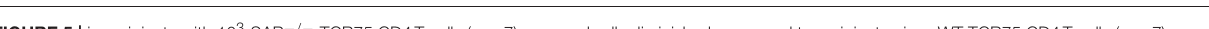
FIGURE 5 | in recipients with 10 3 SAP − / − TCR75 CD4T cells ( n = 7) was markedly diminished compared to recipients given WT TCR75 CD4T cells ( n = 7); * P < 0.001, two-way ANOVA. (C) Whereas BALB/c heart allografts survived long-term in BL/6 Tcrbd − / − recipients reconstituted with 10 3 SAP − / − TCR75 CD4T cells ( n = 7), allografts were rejected in recipients given 1 × 10 3 WT (SAP + / + ) TCR75 CD4T cells ( n = 7, MST-50 days; P < 0.001, log-rank test). (D) Severity of vasculopathy (left) and parenchymal damage (right) in BALB/c hearts explanted: from unmodified (non-reconstituted) BL/6 Tcrbd − / − mice (day 50, n = 4); at d14 ( n = 4) and d50 ( n = 8) from BL/6 Tcrbd − / − recipients reconstituted with WT TCR75 CD4T cells; at d50 from Rag2 − / − recipients reconstituted with WT TCR75 CD4T cells ( n = 5); at d50 from BL/6 Tcrbd − / − recipients reconstituted with 10 3 SAP − / − TCR75 CD4T cells ( n = 5) and at day 50 from Rag2 − / − SWHEL recipients simultaneously transplanted with BALB/c heart and mHEL-Kd skin graft and reconstituted with 10 3 TCR75 CD4 T cells ( n = 5). Each dot represents a single animal; Left : * 1 P = 0.001, * 2 P = 0.008, * 3 P = 0.003, # 4 P = 0.29, Right : * 1 P = 0.008, * 2 P = 0.005, * 3 P = 0.003, # 4 P = 0.18; two-tailed Student’s t -test for normally distributed and Mann-Whitney tests for non-parametric data. (E) Representative confocal immunofluorescence photomicrographs of splenic cryostat sections stained with antibodies against B220 (B cells, green) and CD4 (red) at day 50 after transplantation of BALB/c heart grafts into BL/6 Tcrbd − / − recipients reconstituted with no cells (left), 10 3 Sh2d1a − / − (middle) or wild-type (right) TCR75 CD4T cells (scale bar – 50 µ